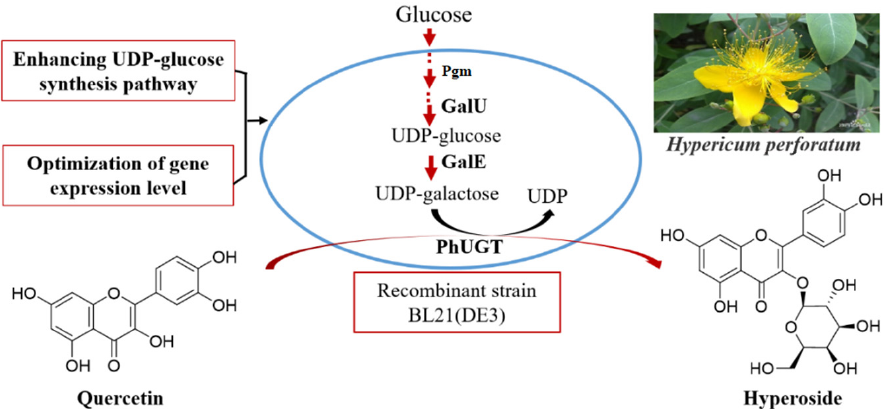
Figure 1. Synthesis of Hyperoside using recombinant E. coli . Pgm, phosphoglucomutase; GalU, UDP-glucose pyrophosphorylase; GalE, UDP-glucose 4-epimerase; PhUGT, UDP-dependent glyco- syltransferases from Petunia hybrida .